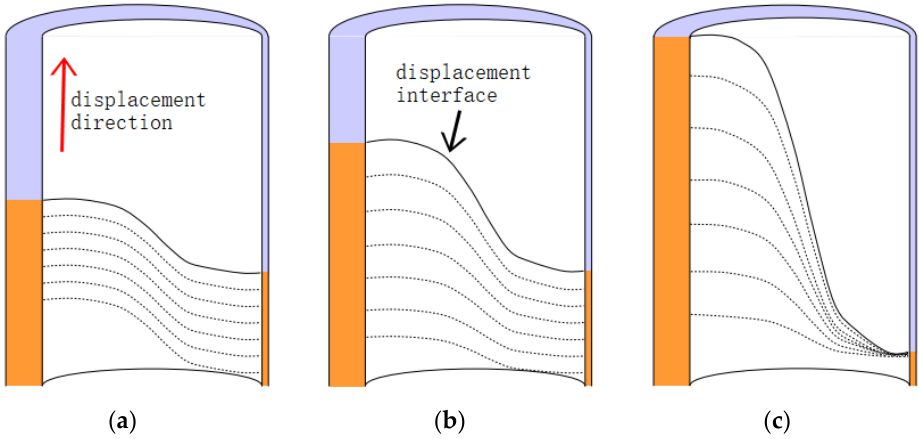
Figure 1. Several cementing displacement interfaces: ( a ) stable displacement interface; ( b ) unstable displacement interface; ( c ) channeling of drilling fluid.